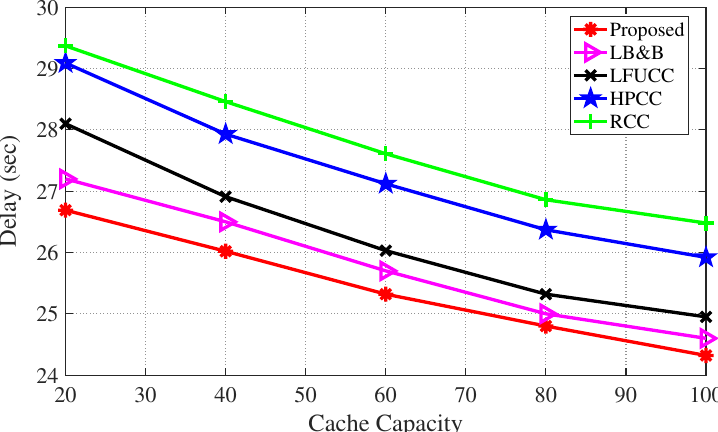
Figure 5. Network delay with respect to increasing users’ density when N = 50, γ = 1, and F = 400.